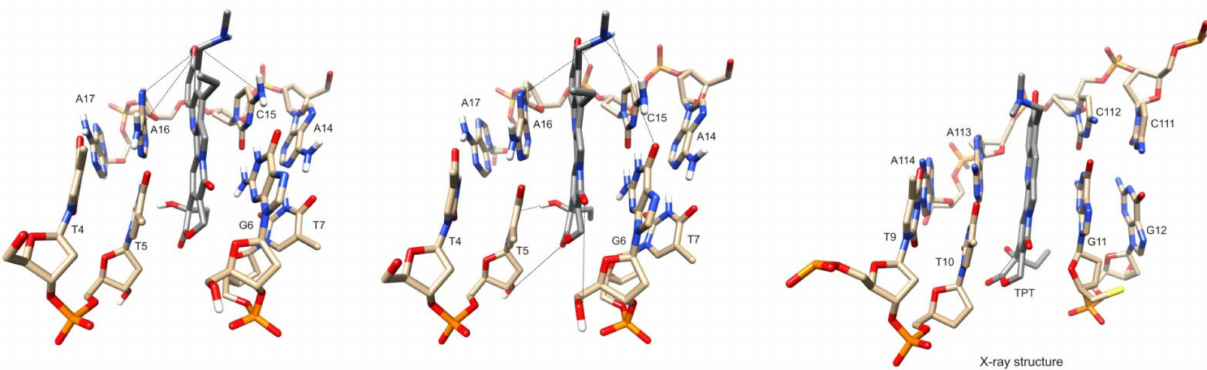
Figure 2. Molecular view of the most probable geometry of complex 1 + 2. Structure 1 is from MD trajectories (Figure S11). The N–CH 3 group is pointing towards a major groove. The left panel shows internuclear contacts for possible hybrid formation. The center panel shows possible hydrogen bond network stabilizing the structure (see Figure S13 and Table S4 for internuclear distances and assignments). For clarity, only two base pairs flanking the nick are shown. Right panel shows the fragment from X-ray complex of nicked 20-mer nicked DNA with topotecan (RCSB PDB:1K4T).